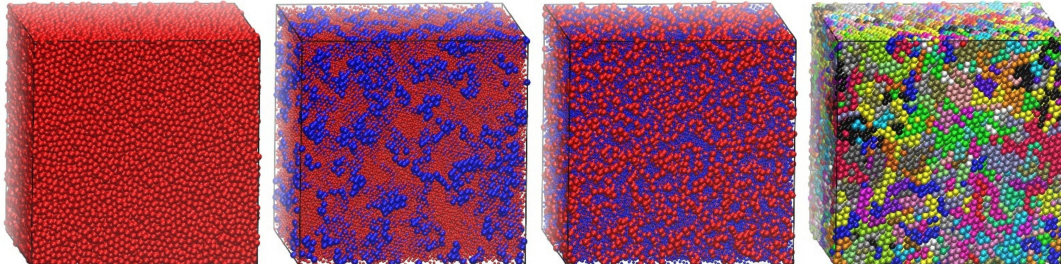
Figure 8. Bulk systems of 54,000 interacting hard spheres with varied relative concentrations of polymer content with chains having an average length of N = 1000 at ϕ = 0.58. The polymer relative concentration ranges from 0, 0.185, 0.741 to 1 (from left to right). In the pure polymer configuration (rightmost panel), sites are colored according to the parent chain. In all other cases, single and chain monomers are shown in red and blue, respectively. For chain concentrations of 0.185 and 0.741, sphere dimensions of dominant species are shown in a 2:5 scale for clarity. Image created with the VMD visualization software [54].